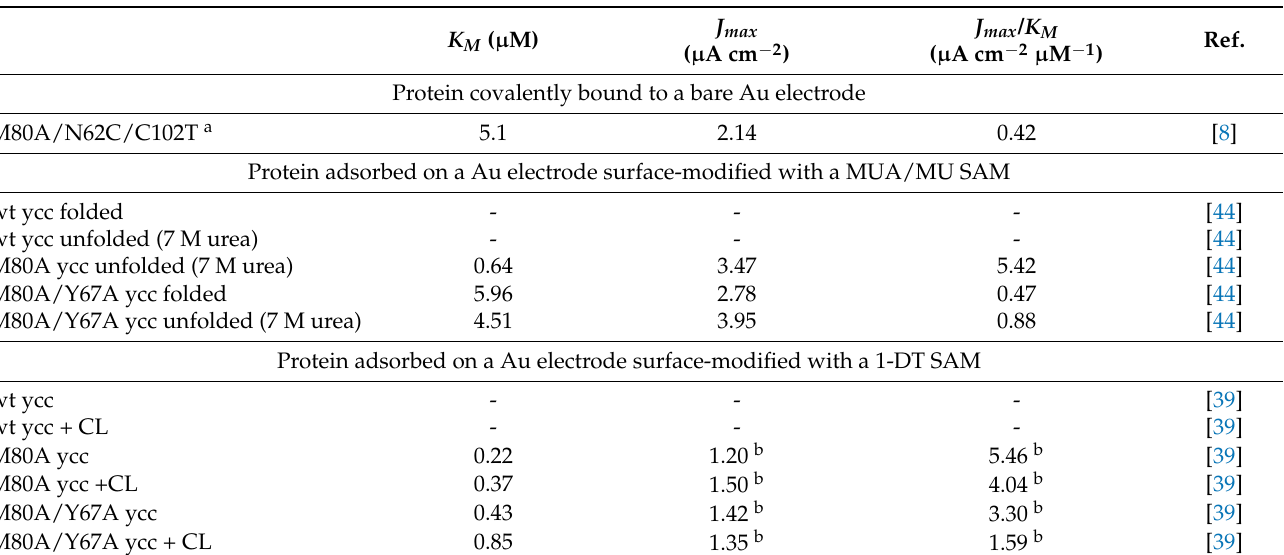
Table 1. Kinetic parameters for the electrocatalytic reduction of NO 2 − carried out by wt yeast iso-1 cytochrome c (ycc) and some of its variants covalently bound to a bare polycrystalline gold electrode (M80A/N62C/C102T) or adsorbed on a polycrystalline gold electrode coated with a SAM of MUA/MU or 1-DT (M80A and M80A/Y67A). For the solution composition, experimental conditions, and uncertainties associated with the reported values, the reader is referred to the original